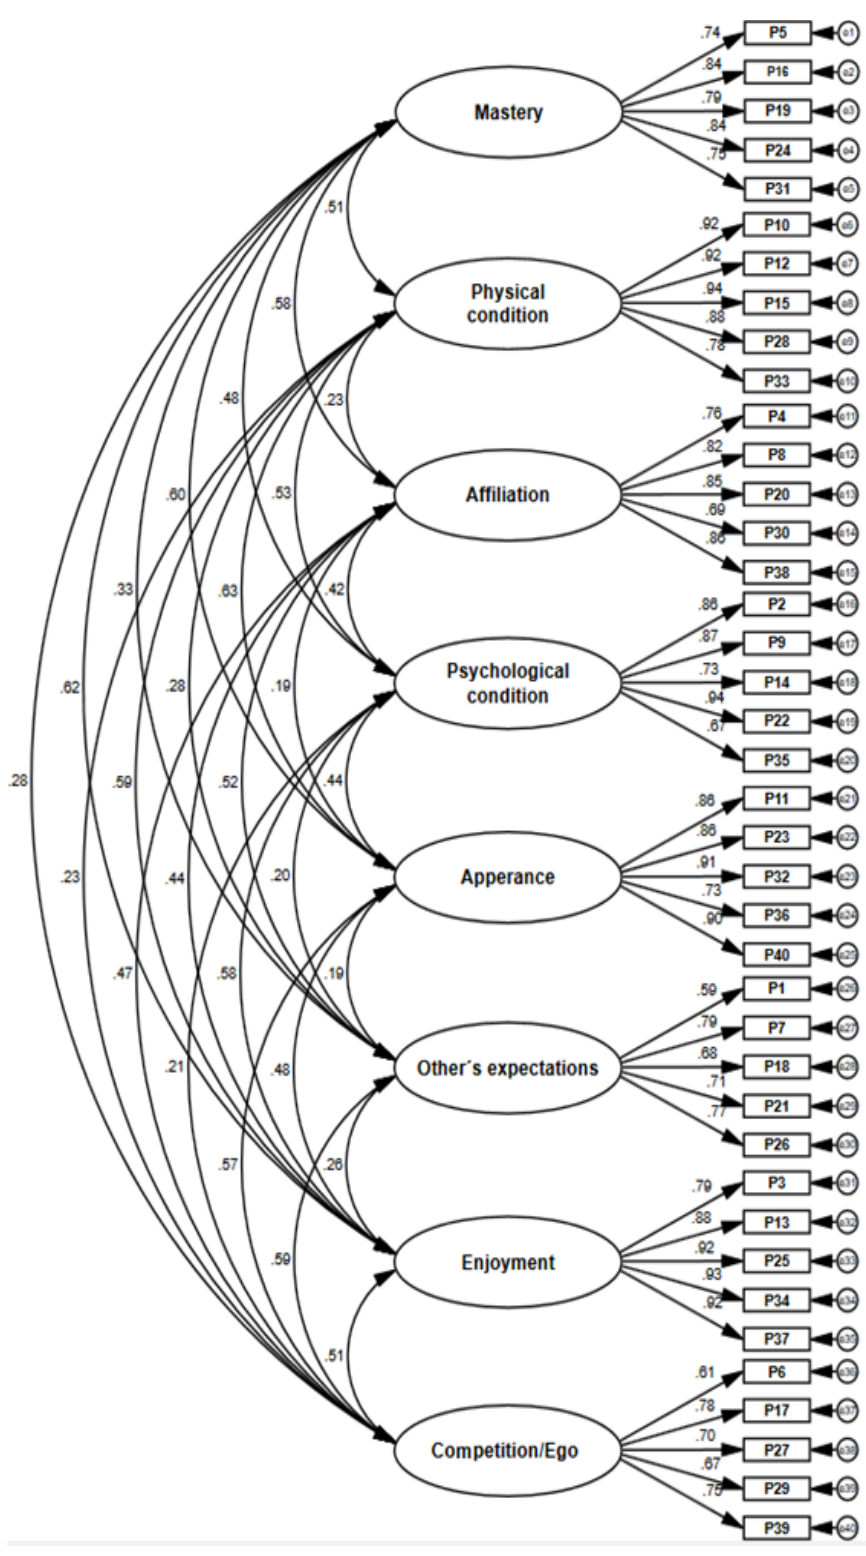
Figure 1. Confirmatory factor analysis.